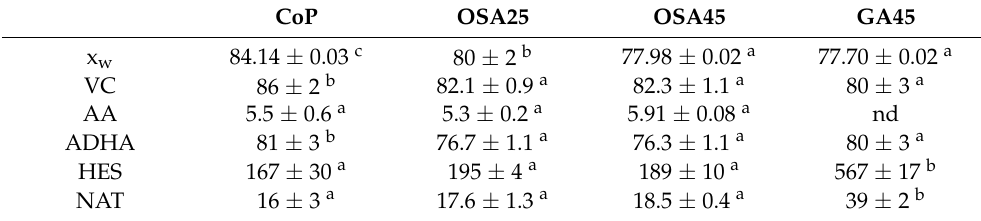
Table 2. Mean water (x w , g water/100 g analyzed sample) and bioactive compound content Table 1): vitamin C (VC), ascorbic acid (AA), dehydroascorbic acid (DHAA), hesperidin (HES), and narirutin (NAT).